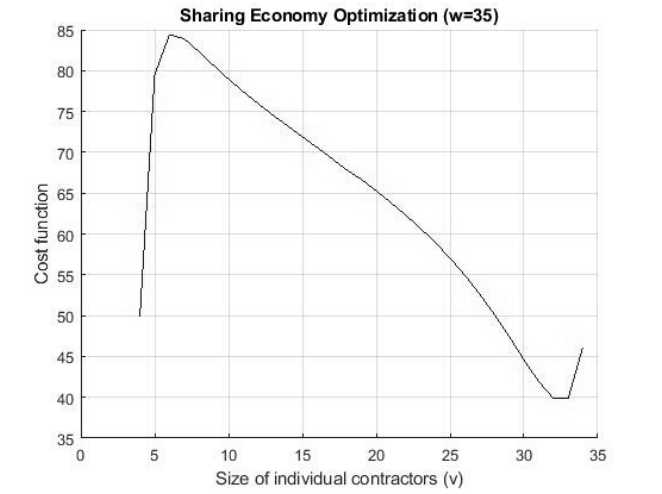
Figure 2. Optimization Example.